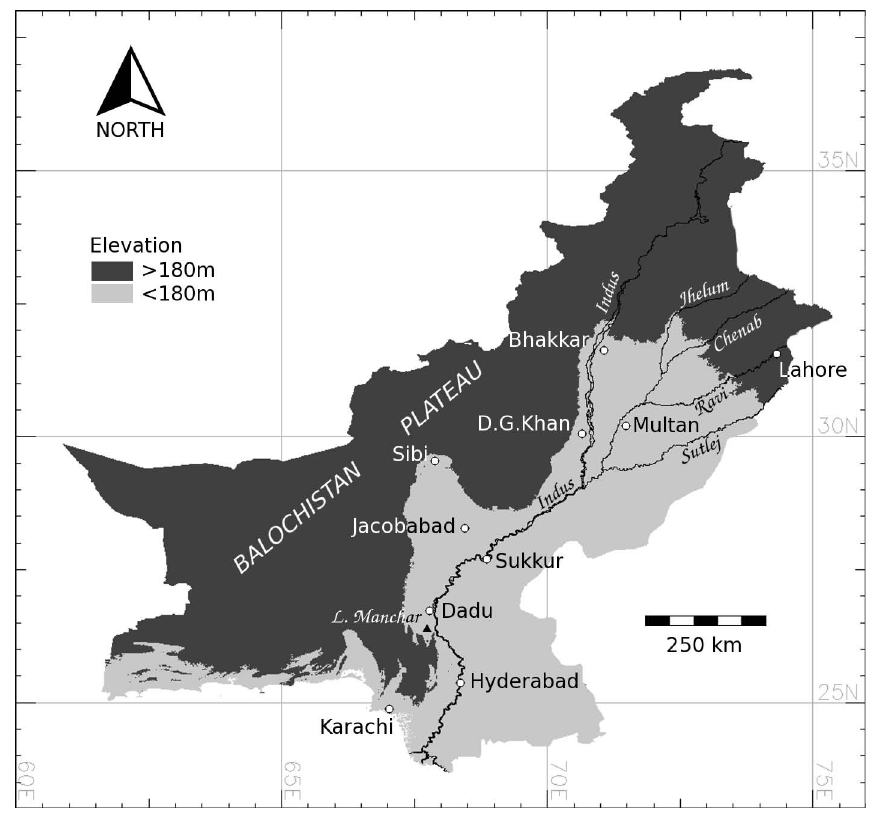
Fig. 1. Pakistan and the Indus-Chenab flood